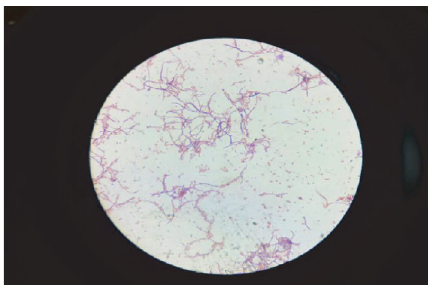
Figure 1: Microscopic observation of actinomycetes isolated. The microscopic observation of actinomycetes using the Gram staining method. Gram-positive red color rod-shaped bacteria with branch network of hyphae are observed under the